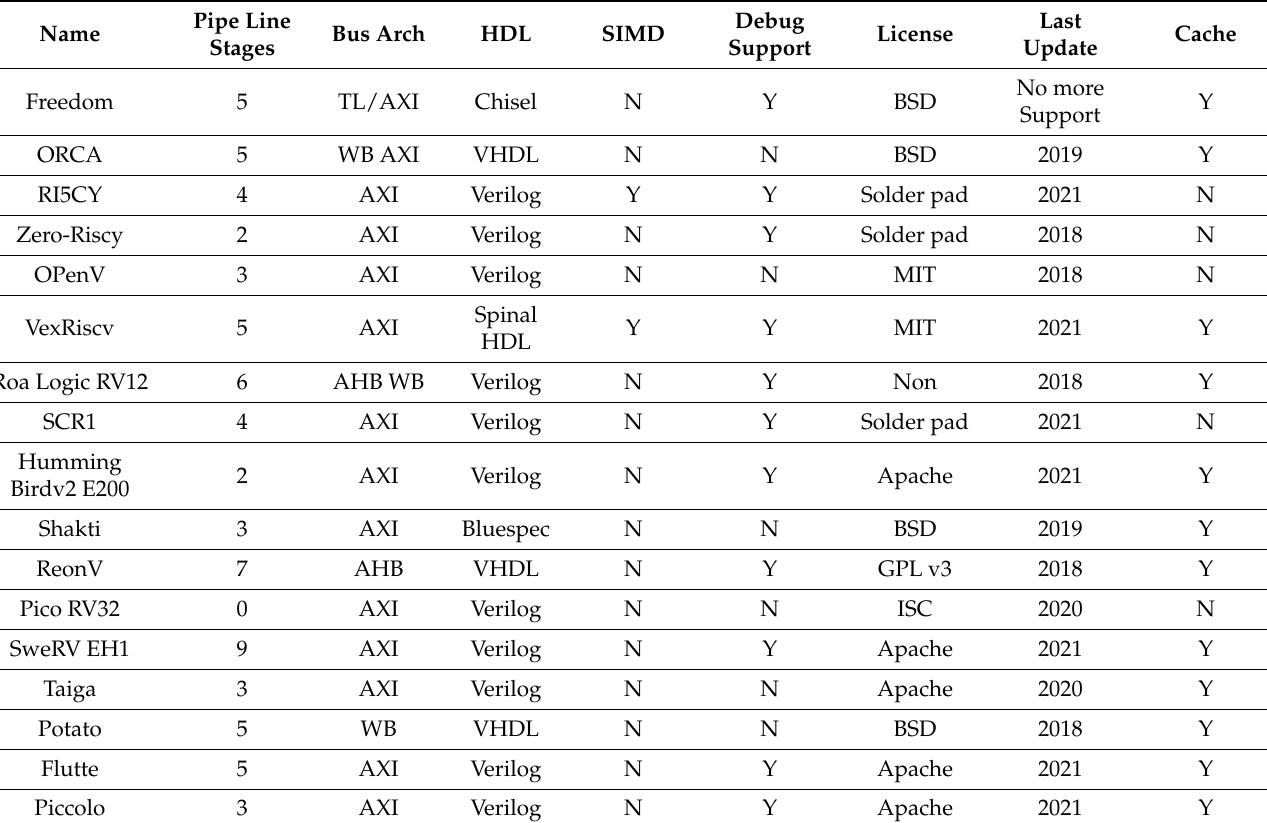
Table 1. Properties of selected 32-bit RISC-V cores. Adapted from [10] and from own